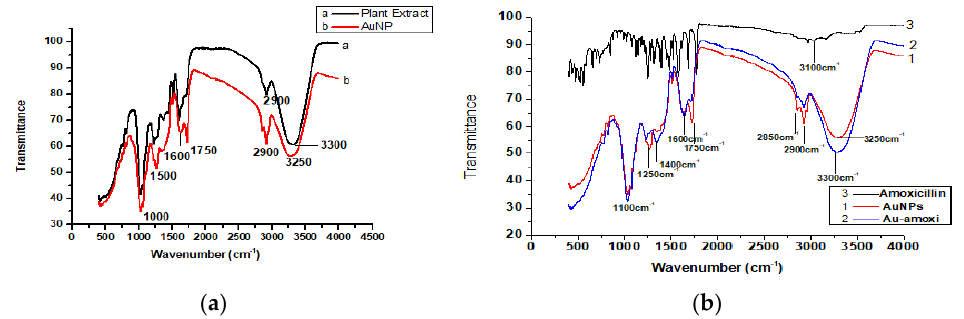
Figure 2. ( a ) FT–IR spectra of flavonoids extract of Micromeria biflora and AuNPs; ( b ) FT–IR spectra of AuNPs and Au–amoxi conjugate.